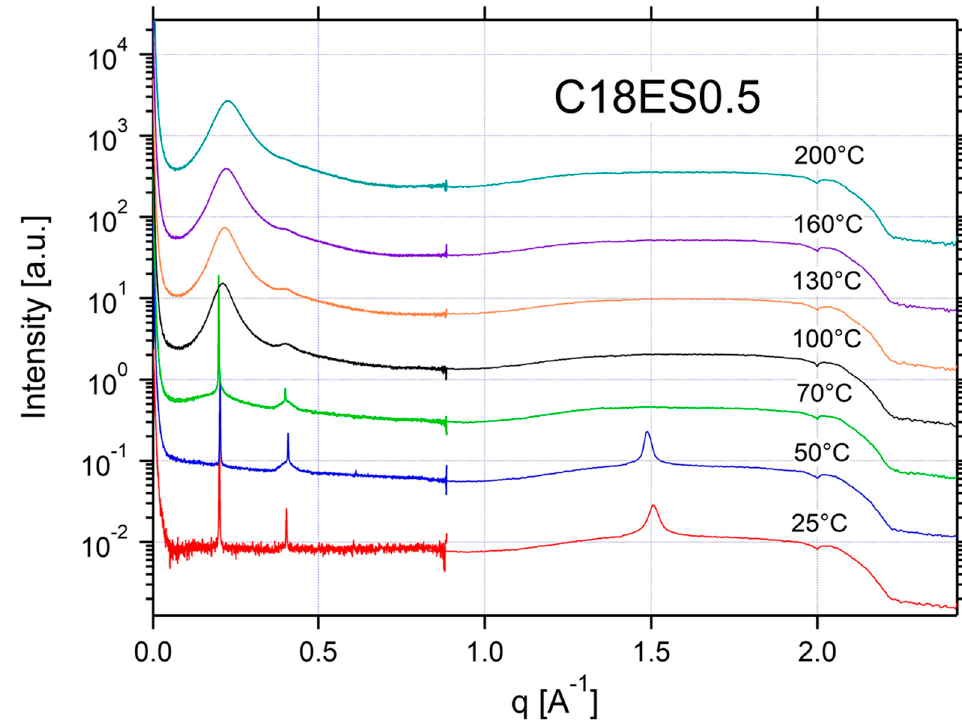
Figure A19. SAXS and WAXS data for 0.5:1 C18ES:C18LiTFSI.